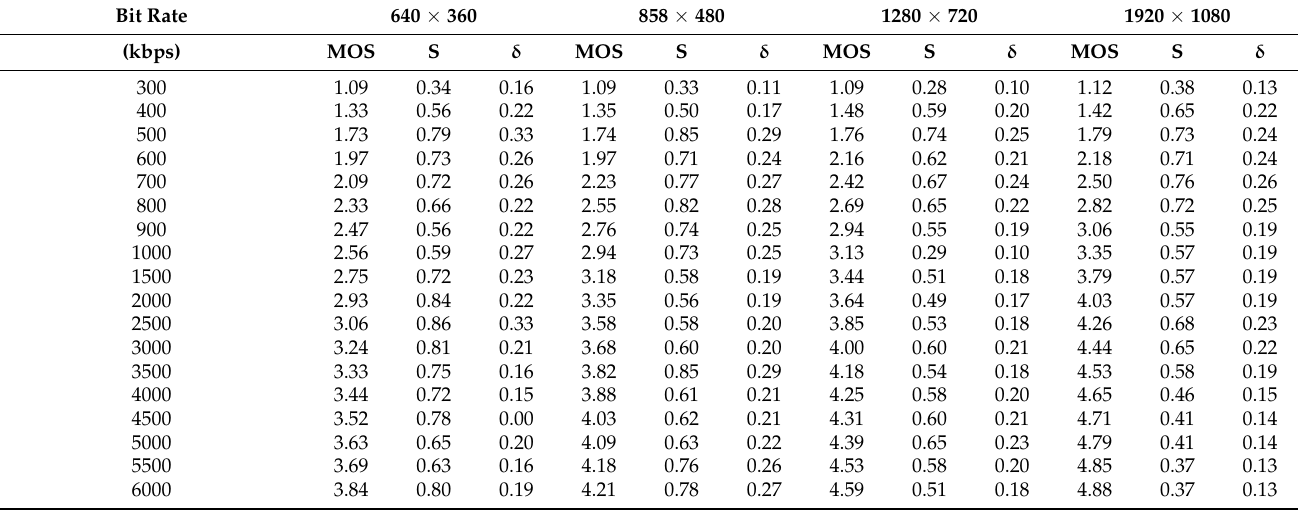
Table 4. Mean value of the video quality assessment (MOS) for H.265 codec, standard deviation (S), and confidence interval coefficient ( δ ) for four resolutions—measurements at